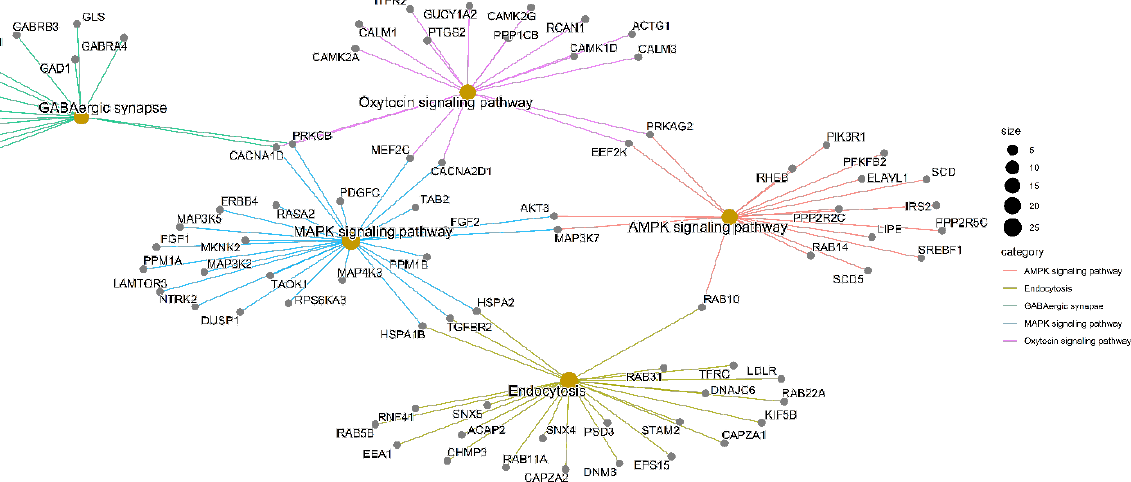
Figure 1. Enrichment network for results obtained from the hypergeometric enrichment test: link- ages of genes, GO biological process, and enriched terms are connecting overlapping gene sets.